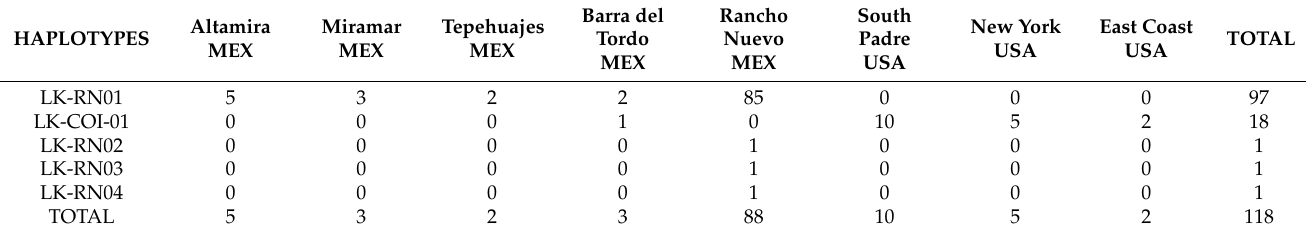
Table 2. The number of Lepidochelys kempii individuals for each haplotype found in each locality.